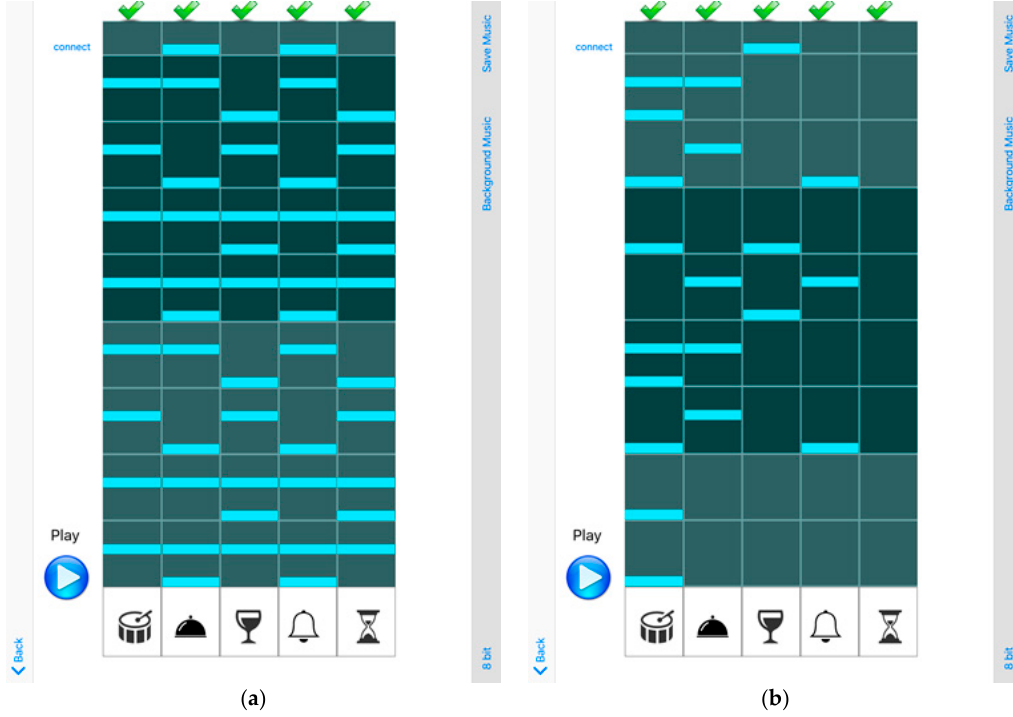
Figure 12. ( a ) Student’s score; ( b ) reforming a better score by the teacher.